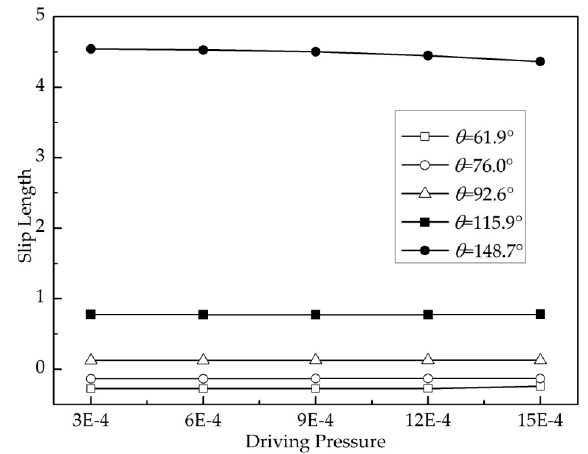
Figure 11. Slip length against driving pressure.